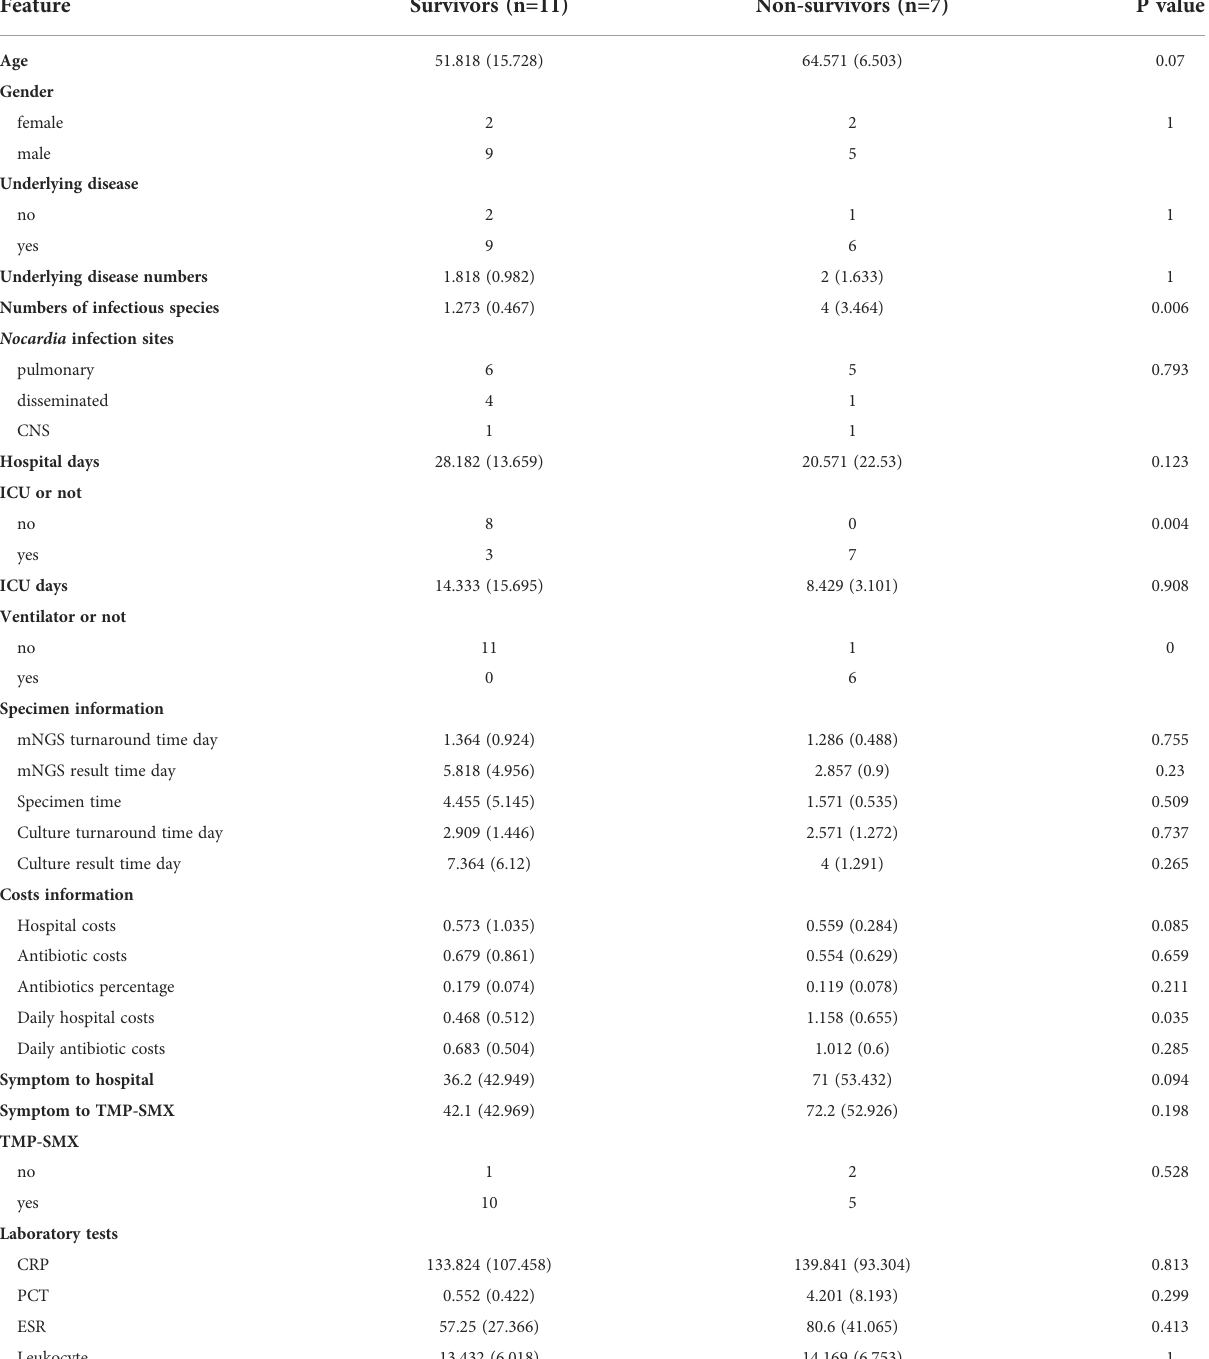
TABLE 3 The comparison of characteristics between survivors and